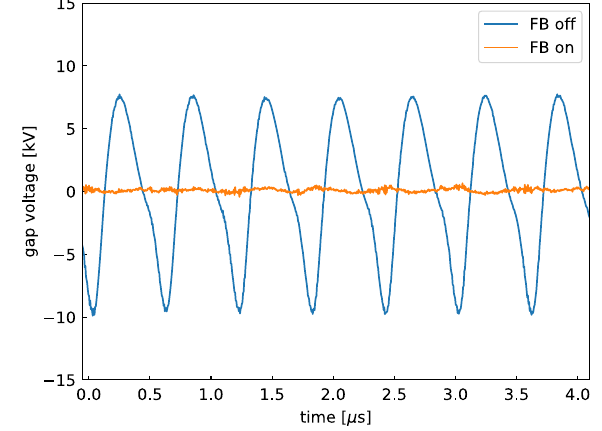
FIG. 30. Comparison of the gap voltage waveforms in the case of acceleration of two bunches without and with feedback just before extraction at 19.9 ms.